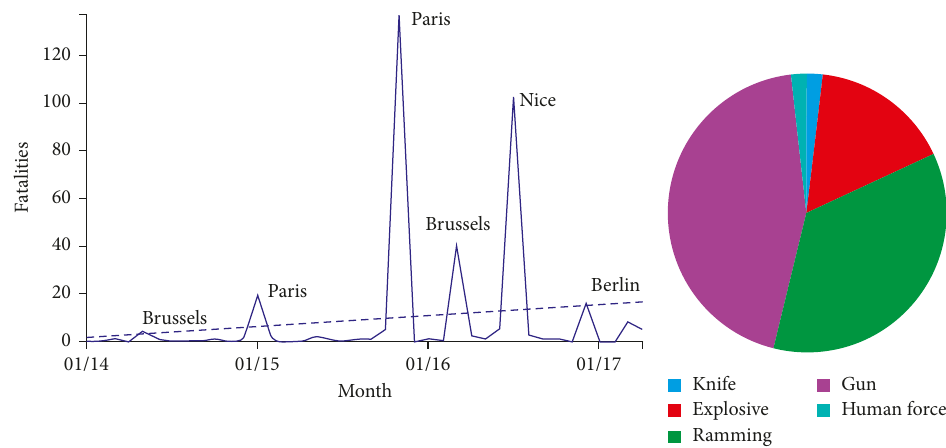
Figure 1: Fatalities due to terrorist attacks in the European Union 2014–2017, modus